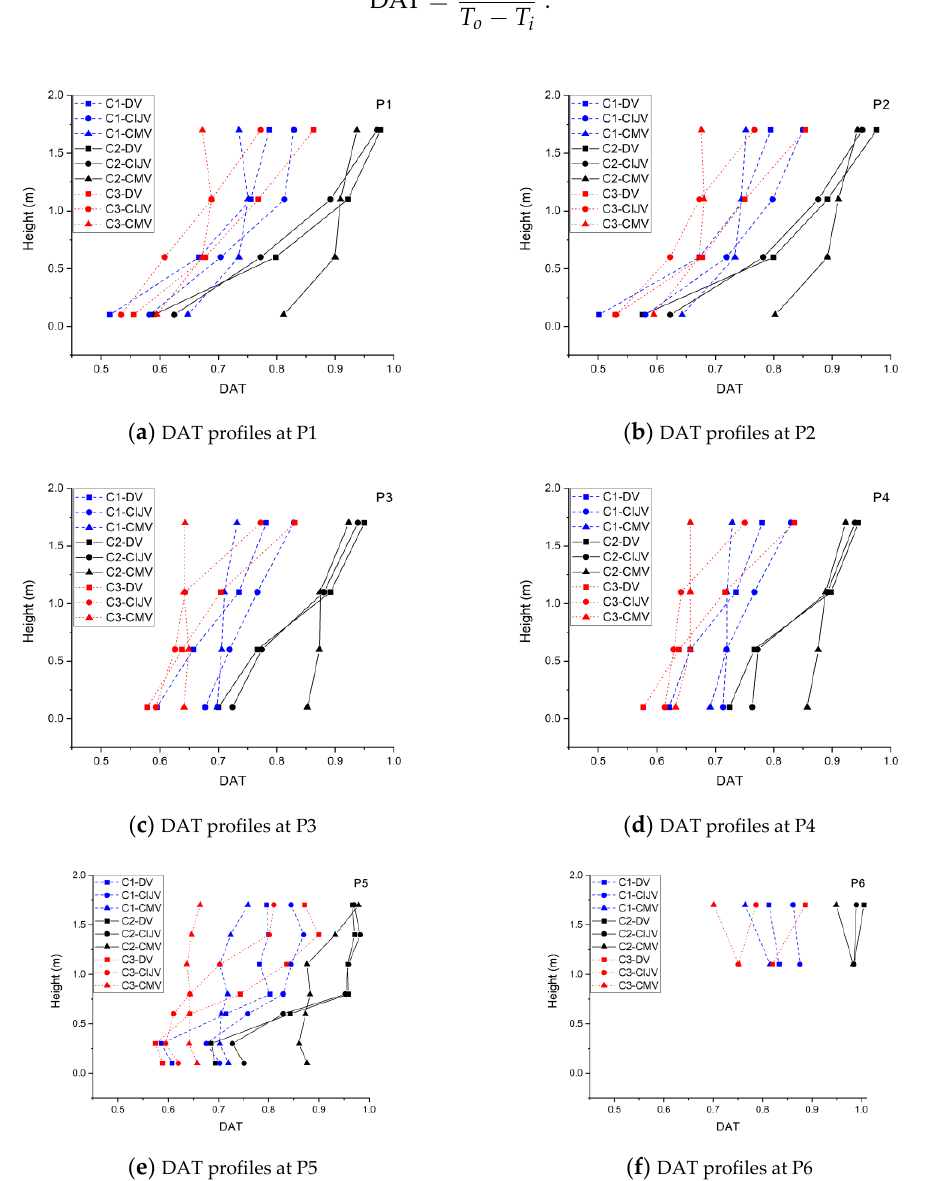
Figure 3. Dimensionless vertical air temperature (DAT) profiles at positions P1 ( a ), P2 ( b ), P3 ( c ), P4 ( d ), P5 ( e ), and P6 ( f ) for all cases.